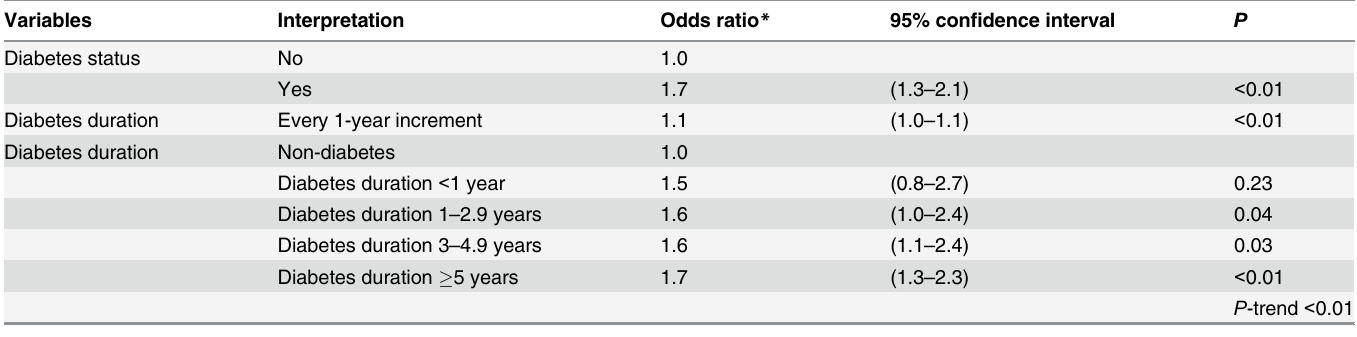
Table 3. Multivariable-adjusted odds ratios for kidney cancer with regards to diabetes status and diabetes duration (either treated as a continuous variable or categorized into subgroups).